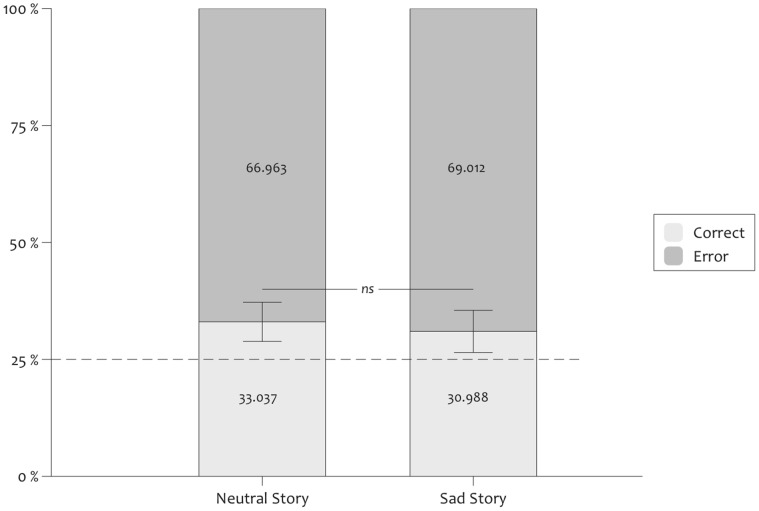
Guessing criteria.Proportion of correct completions when participants who performed above chance level in the completion task claimed to guess, represented separately for sad and neutral mood groups.